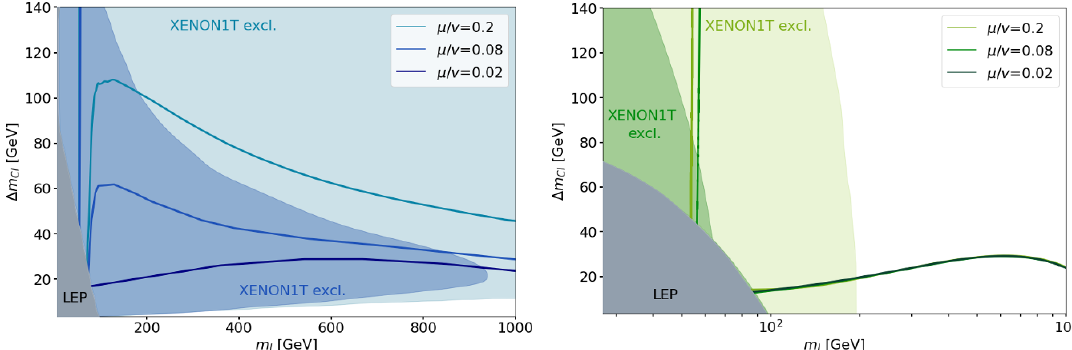
Figure 3 . Relic dark matter abundance in the scalar scenario (left) and pseudo-scalar scenario (right). Colored curves show the observed abundance of (cid:10) (cid:31) h 2 = 0 : 12 for (cid:12)xed values of (cid:22)=v . Shaded regions are excluded by Xenon1T at 90 % CL [32] for the value of (cid:22)=v of the same color. The grey region is excluded by